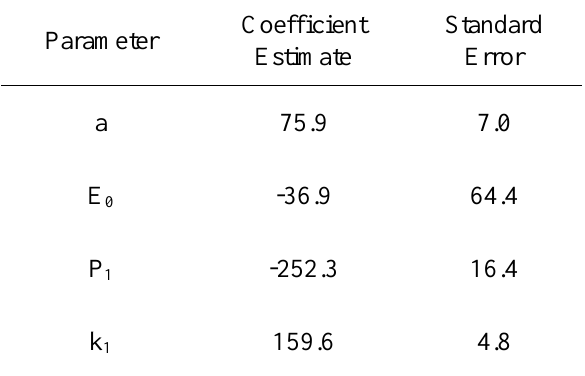
Figure 7. Relationship between below-ground respiration CO corrected to 10 °C (d, e, f) and water table depth (cm below ground surface) with total below-ground (a, d), heterotrophic below-ground (b, e) and autotrophic below-ground (c, f) respiration. Outliers ( × ) excluded from analysis. Table 3. Net ecosystem exchange model (Equation 3) coefficients and standard errors (r 2 =